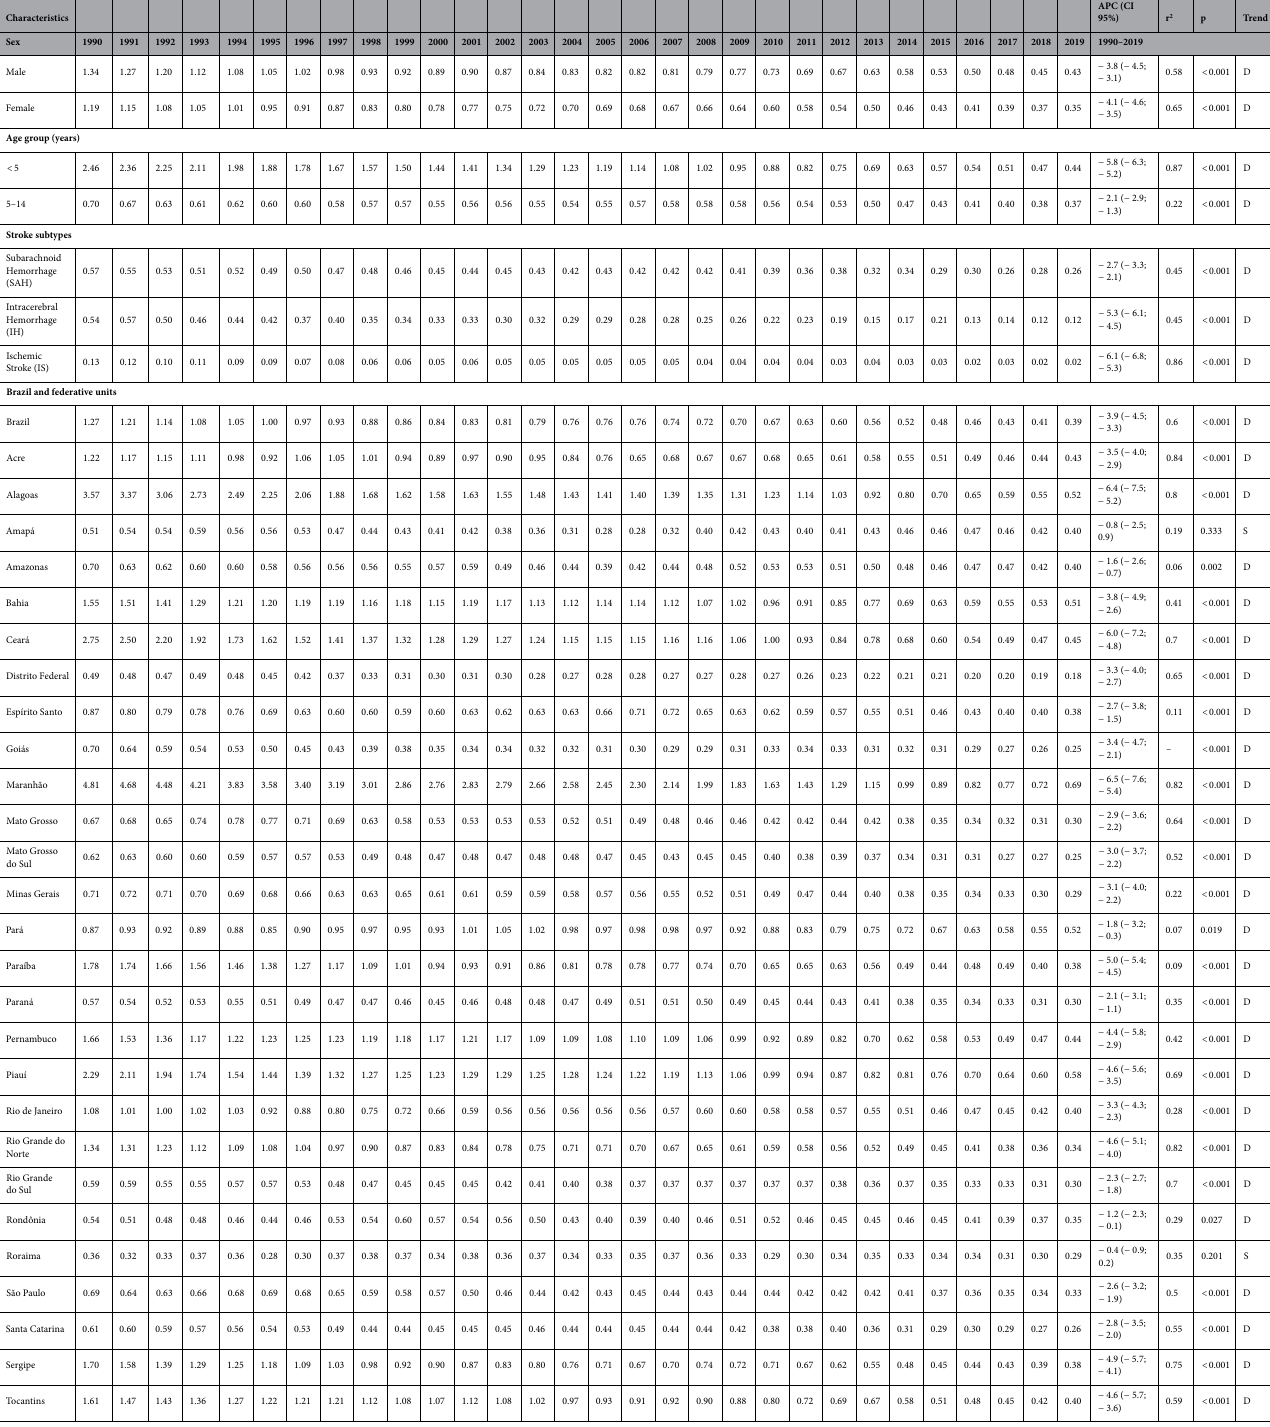
Table 1. Mortality rate temporal variation according to sex, age group and locations from 1990–2019. APC annual percentage change, r 2 predictive capacity of the model, p probability, D decreasing trend, S stationary